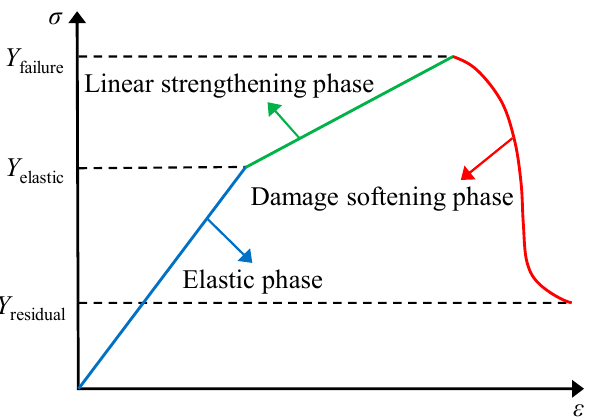
Figure 3. Illustration of the RHT constitutive model.